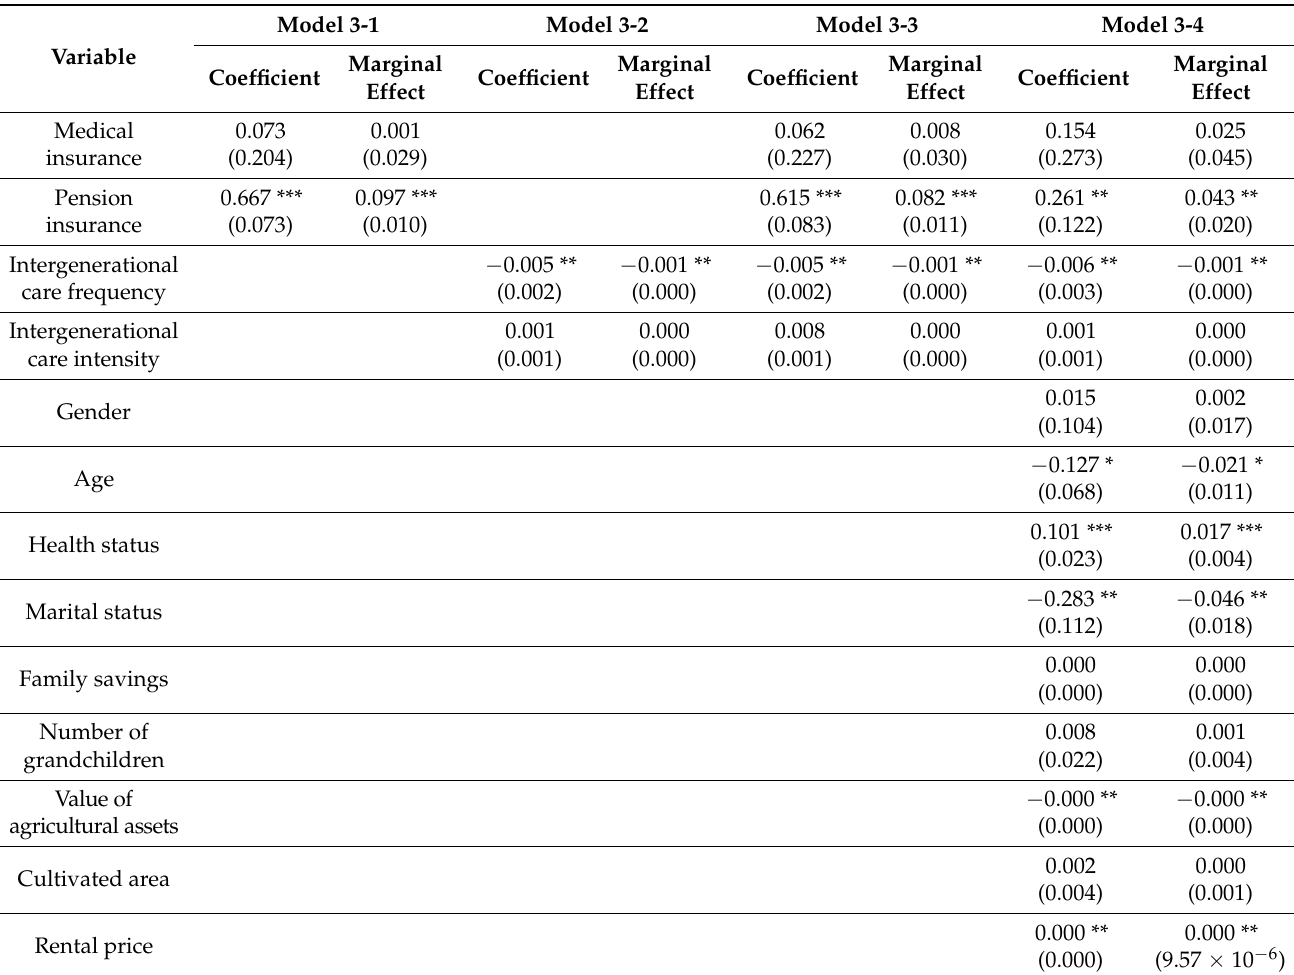
Table 3. Effects of social security and intergenerational care on elderly farmers’ cultivated land renting out